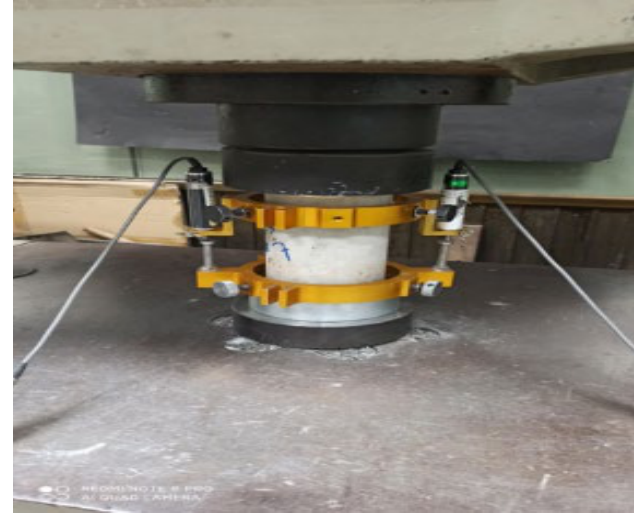
Figure 4. Cylinder compressive strength test with LVDT. Table 5. A mix of unit weight ≤ 1825 kg/ m 3 fc’(MPa) without fiber.